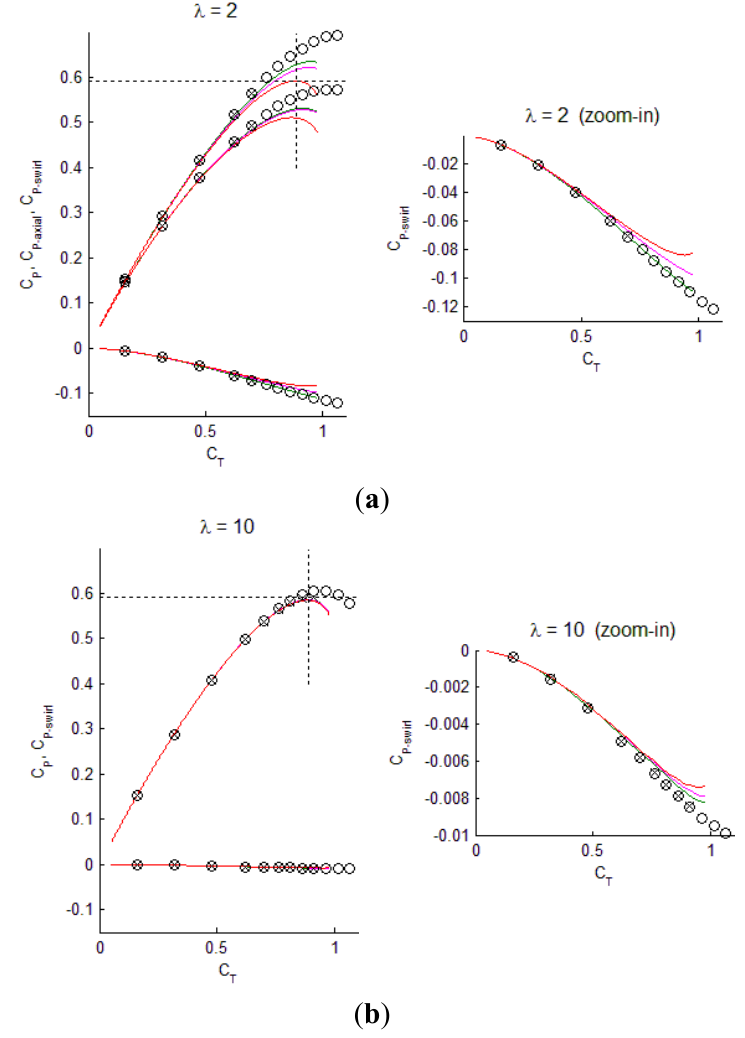
Figure 8. BEM and AD rotor-averaged HAWT power-performance comparison for low TSR ( a ) and high TSR ( b ) versus thrust coefficient, C T